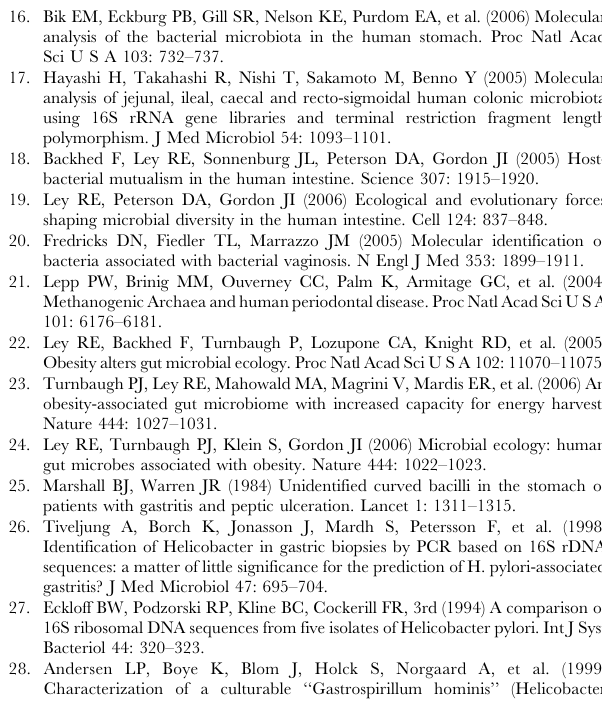
Found at: doi:10.1371/journal.pone.0007985.s006 (0.03 MB Table S2 Species richness estimate in different biopsy